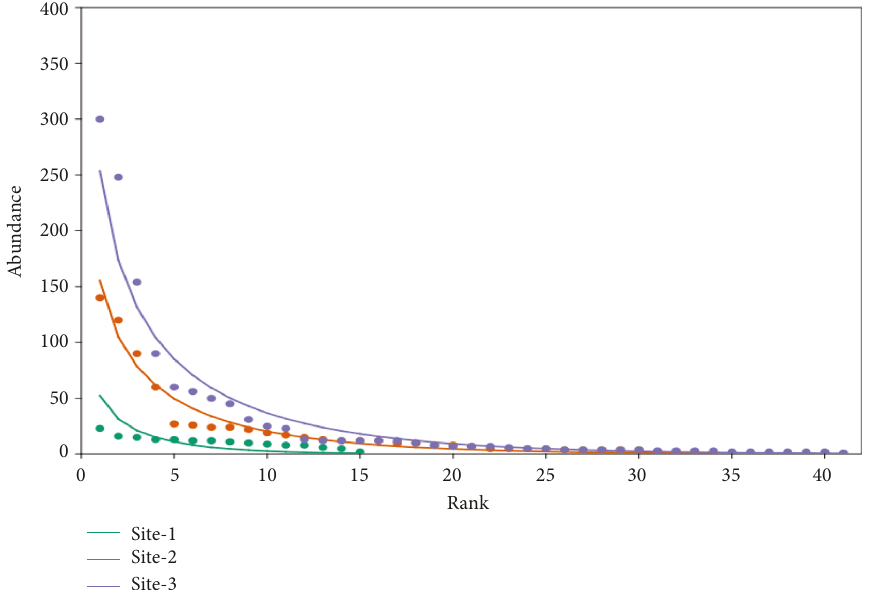
Figure 5: Rank abundance curve for plant species of three distance sites of the study area.